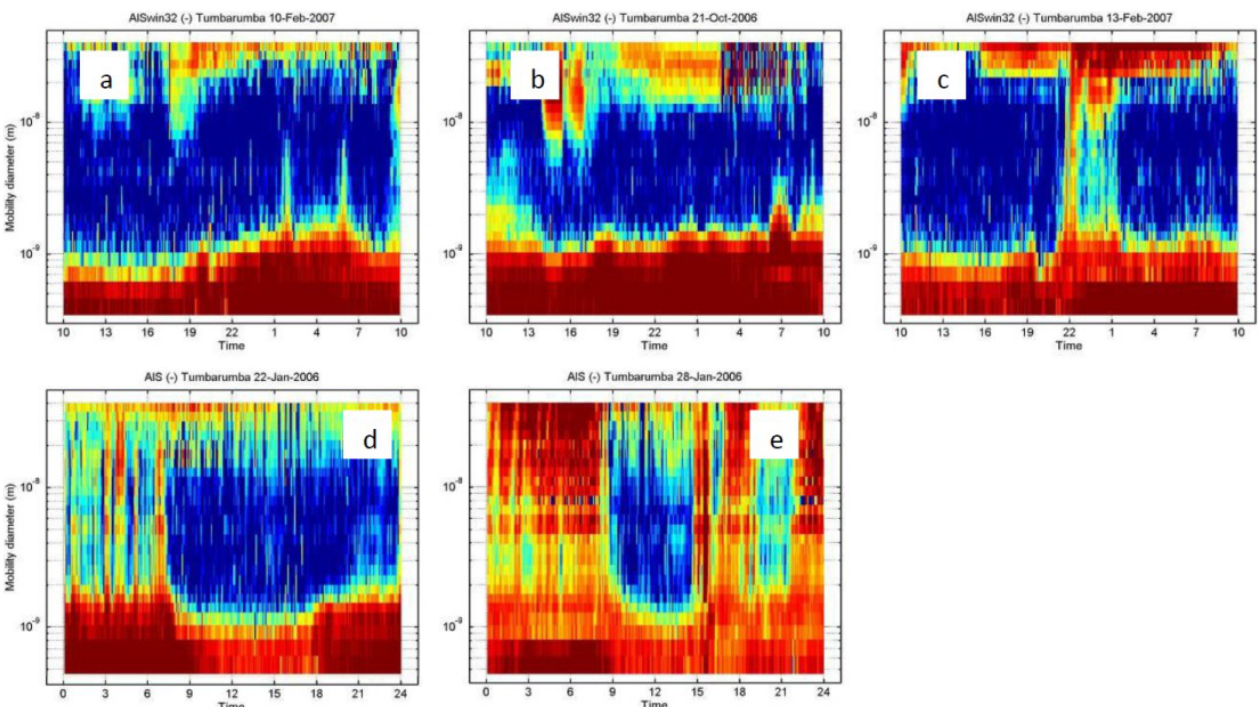
Fig. 7. Nocturnal event classification based on measurement in Tumbarumba in 2005–2007. (a) spikes: two clear spikes in the early morning hours; (b) a bump at 07:00; (c) a typical nocturnal banana at 22:00, more upright than a daytime banana; (d) a stick series in the early morning hours – the most common nocturnal event type; (e) a curtain in the early morning hours and in the late evening after 21:00. Between the curtains there was